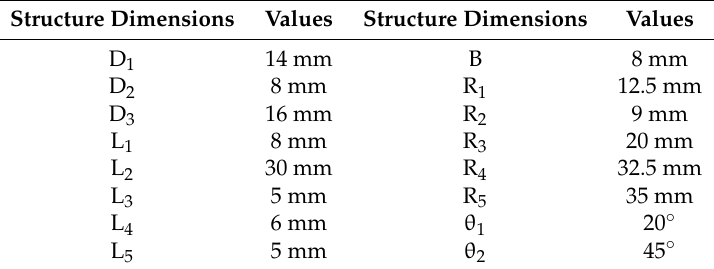
Table 1. Specific structure dimensions.